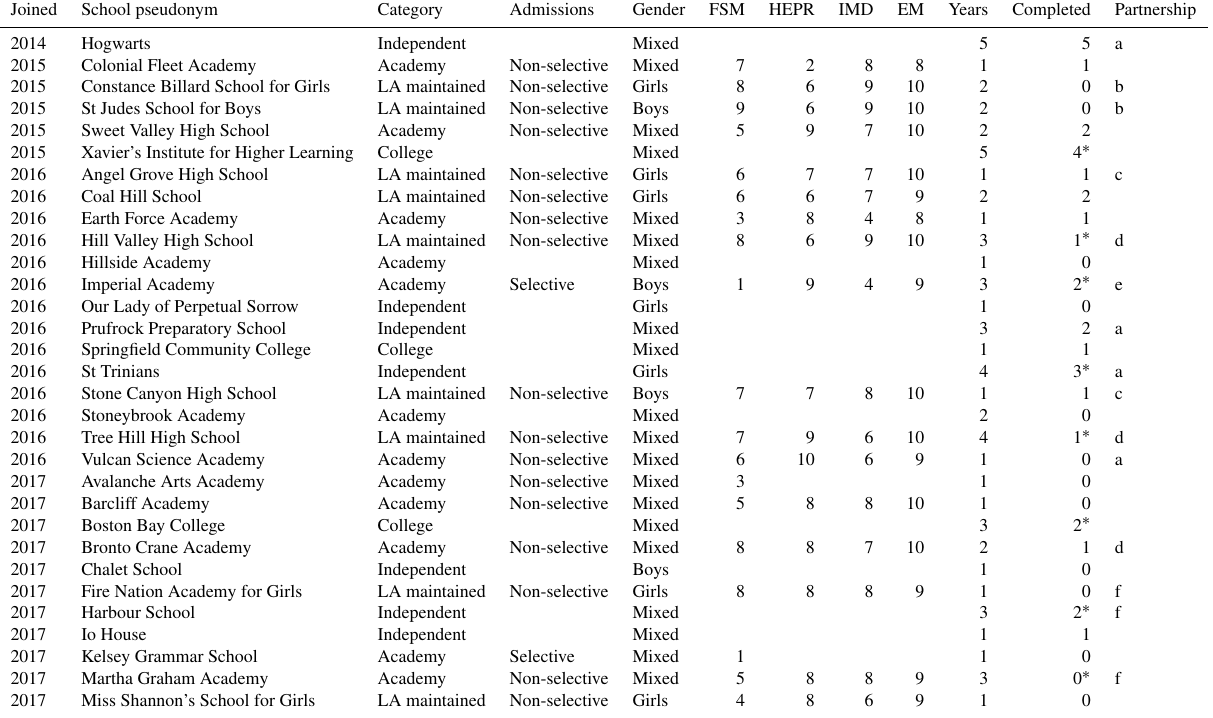
Table A1. Information about all the schools which have been involved in PRiSE. Joined School